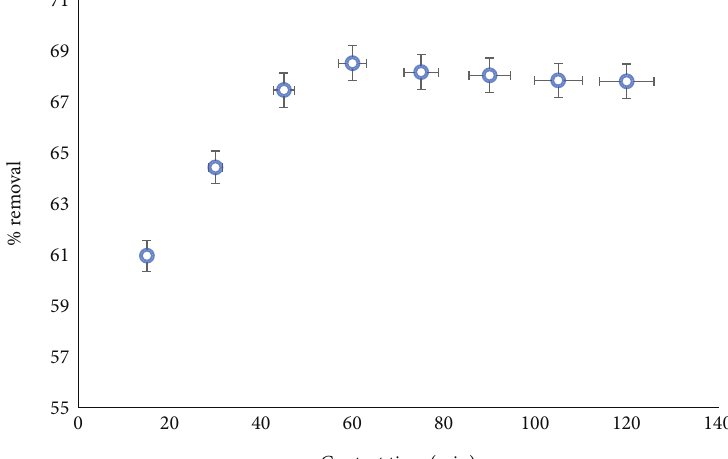
Figure 4: In fl uence of adsorbent dosage on the adsorption of PA onto ACO ( dosage = 10 – 100 mg , C time = 60 min , and T = 25 ± 1 ° C).